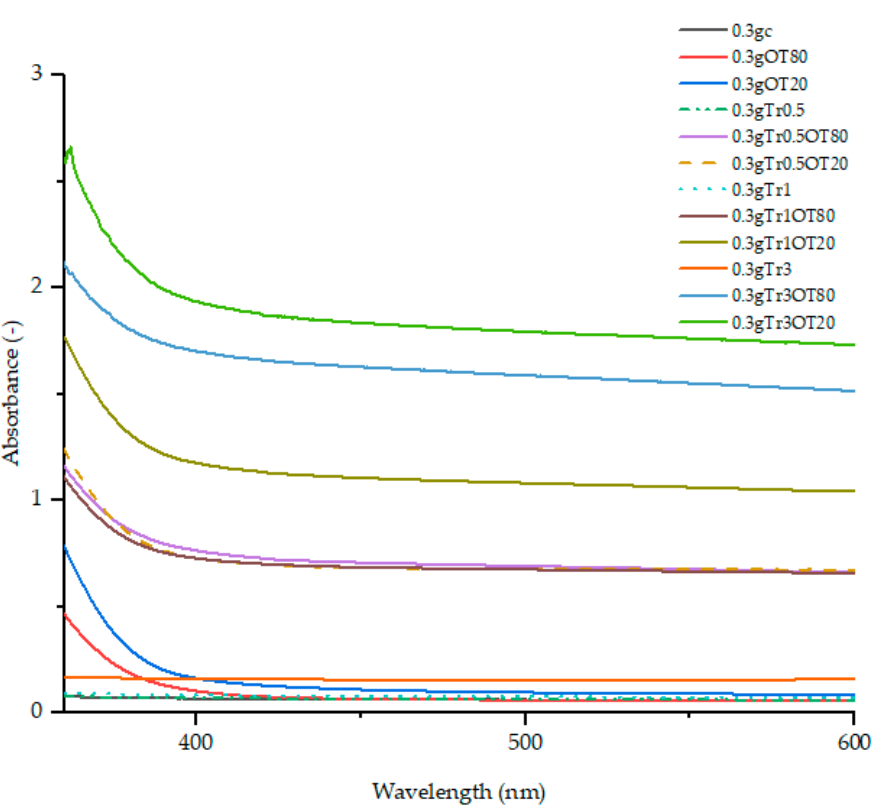
Figure 2. UV-Vis spectra of films with the addition of 0.3 g κ -carrageenan.